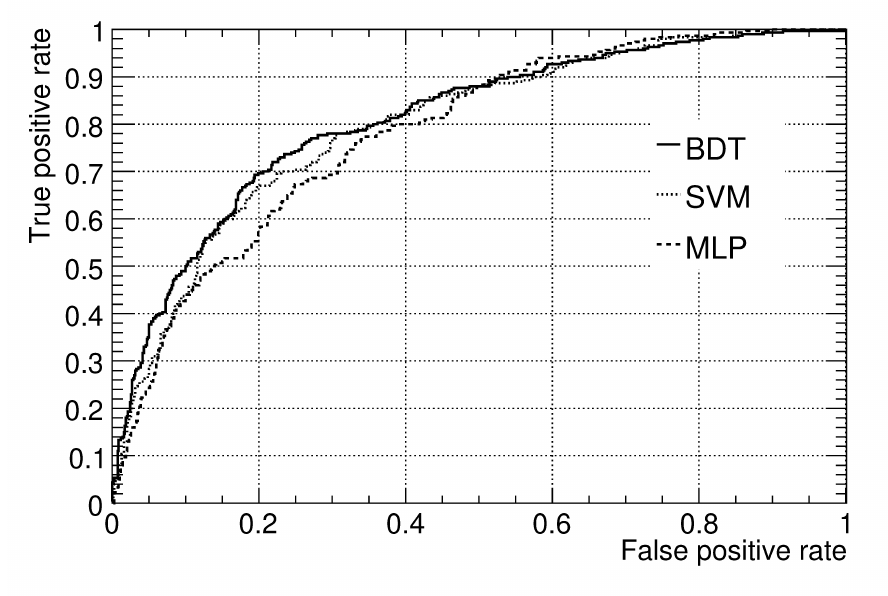
Figure 2. Receiver operating characteristics (ROC) curve for the multilayer perceptron (MLP), support vector machine (SVM), and boosted decision trees (BDT), for the German credit dataset.